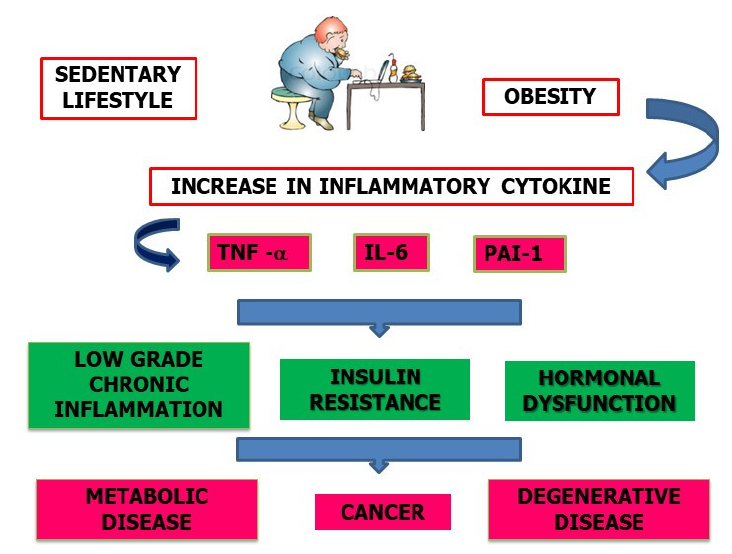
Figure 1. Schematic representation of the consequences due to a sedentary